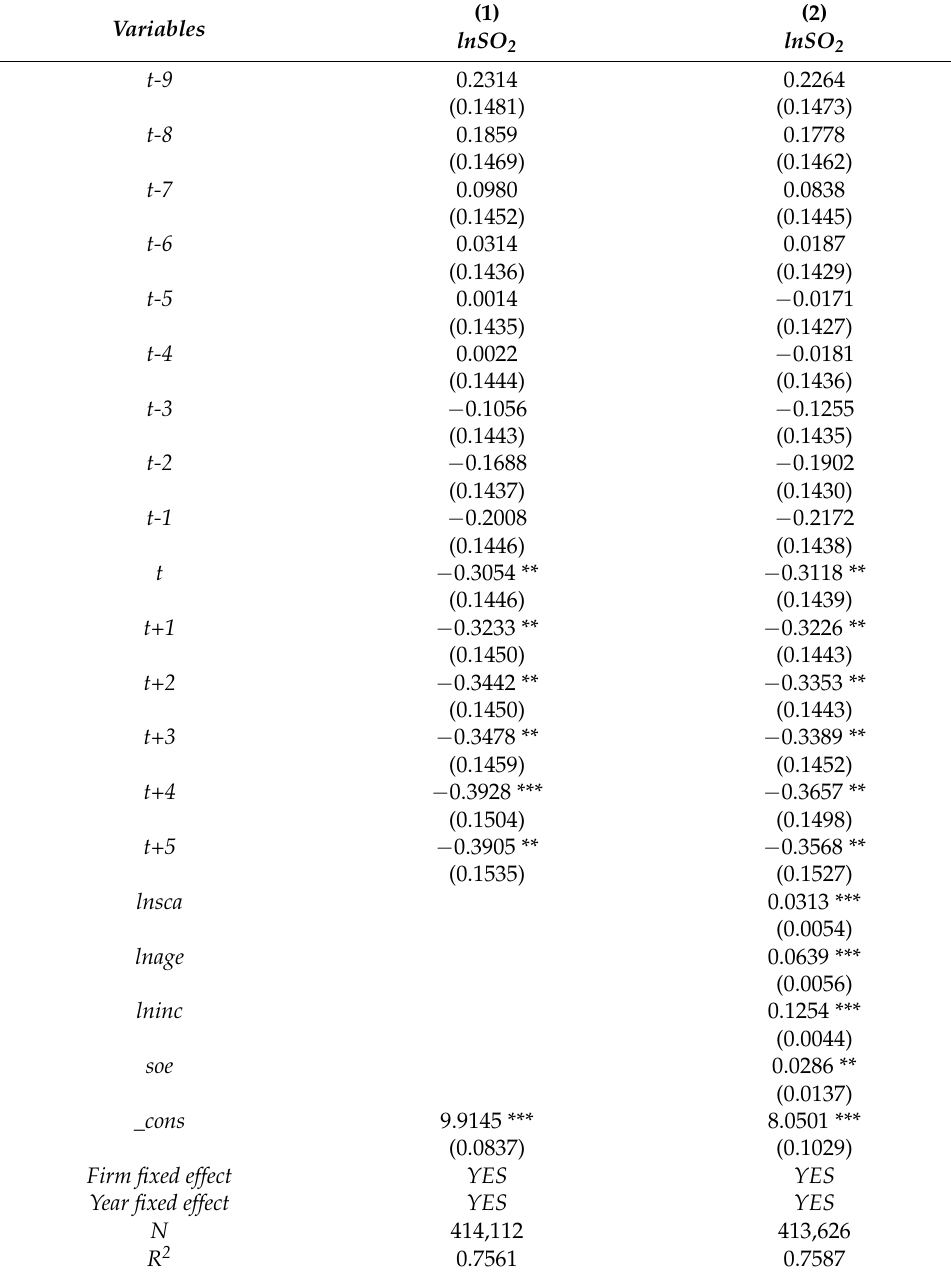
Table 2. Parallel trend